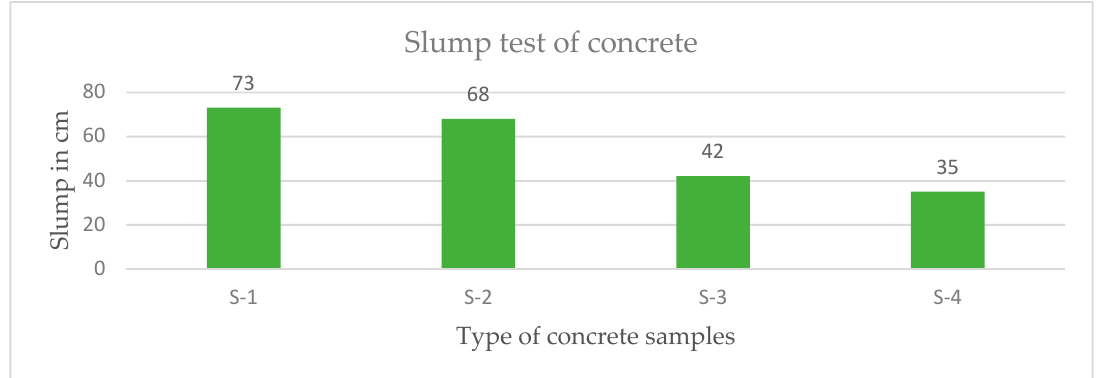
Figure 2. Slump value of concrete specimens.